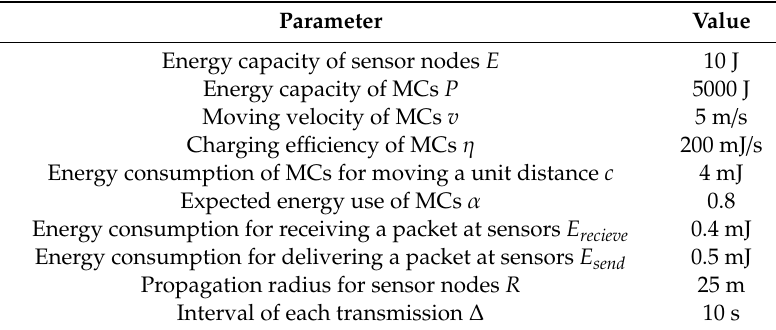
Table 1. Experiment parameter settings.